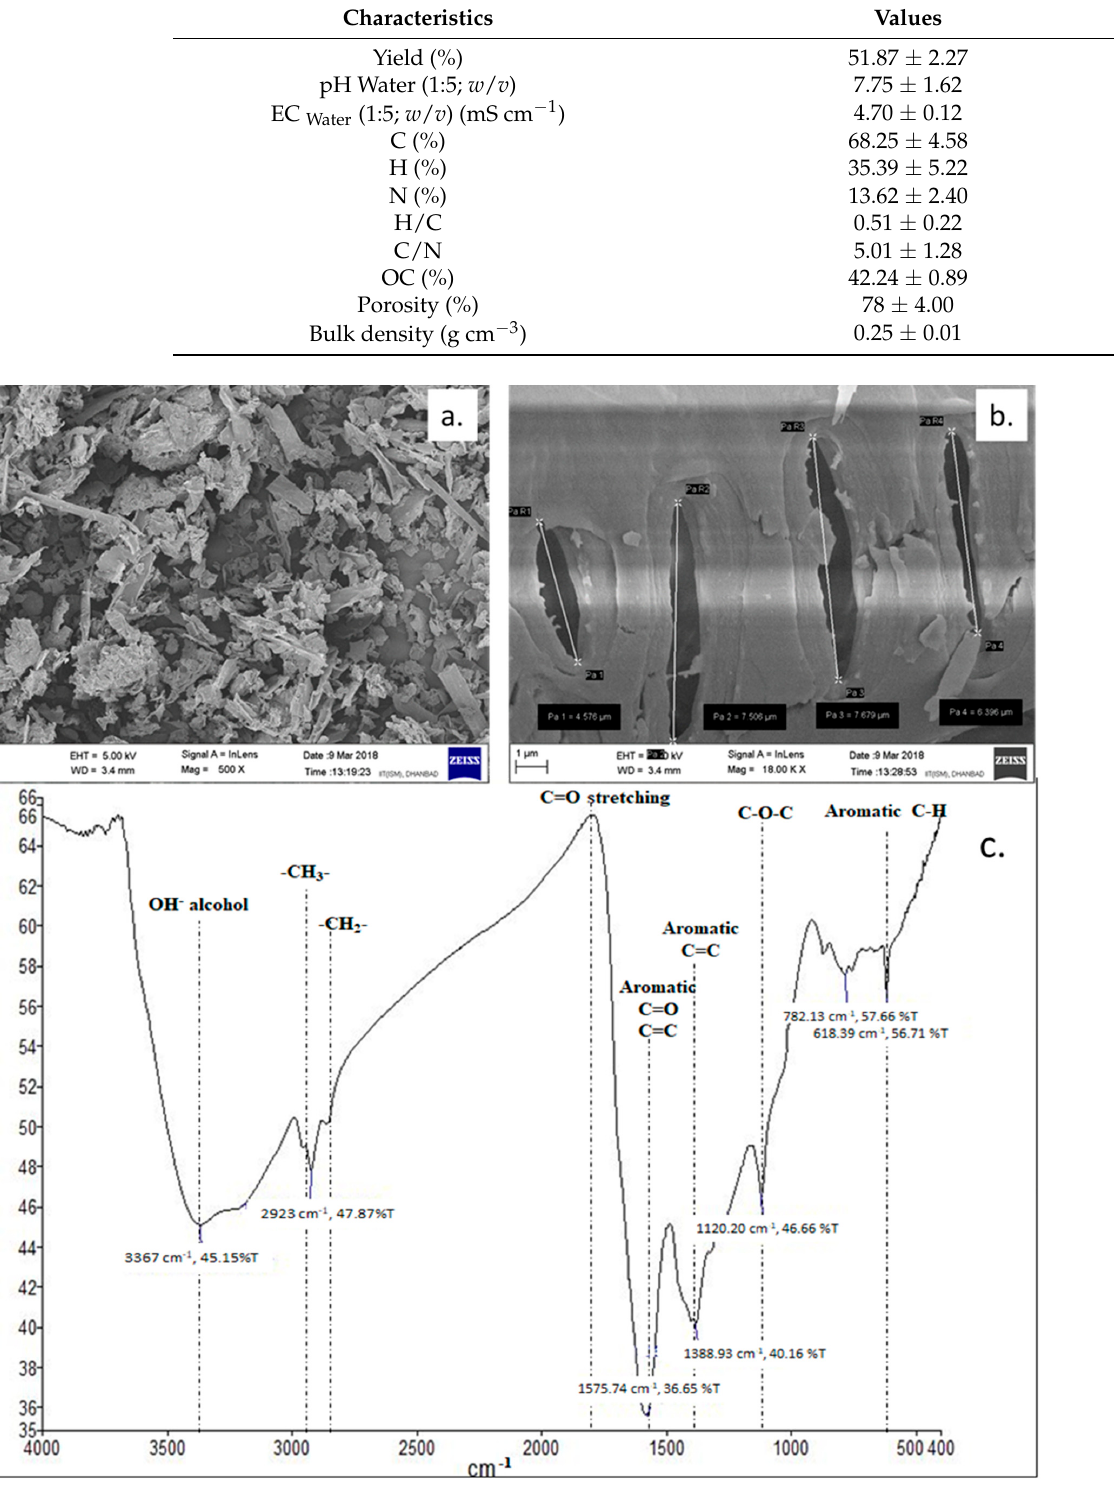
Figure 4. ( a ) FE-SEM image of C. procera biochar at 500 × magnification, ( b ) FE-SEM image of C. procera biochar at 1800 x magnification showing the pore sizes, ( c ) FTIR spectra of C. procera biochar showing the surface functional groups.